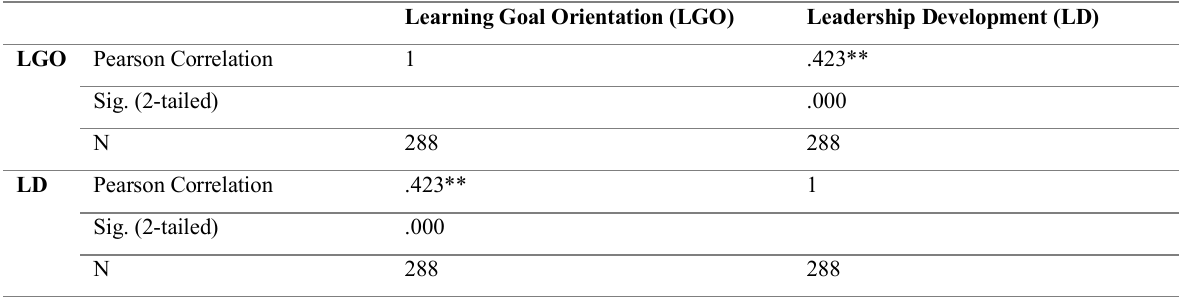
Table 1: Correlation between Learning Goal Orientation and Leadership Development